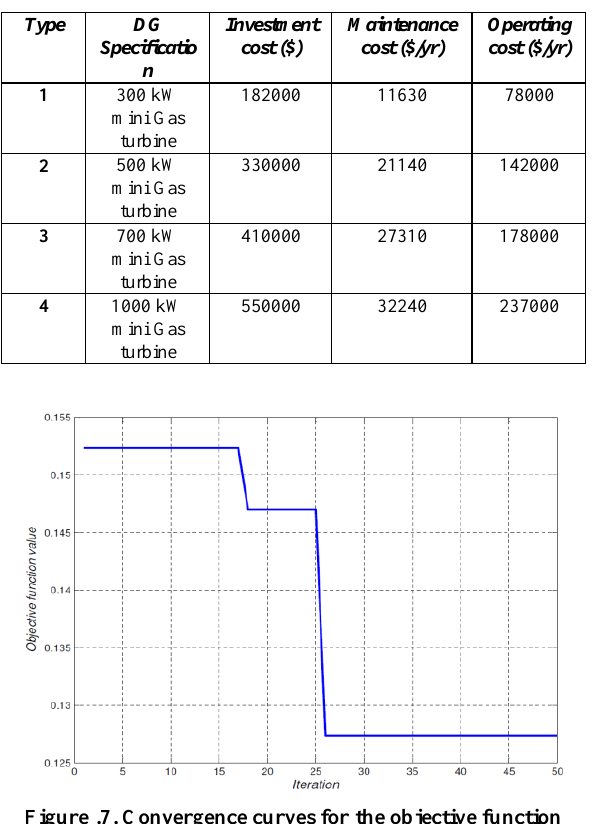
Table 1. The cost for dg types